Question: Which kind of chart has been used to present this data?
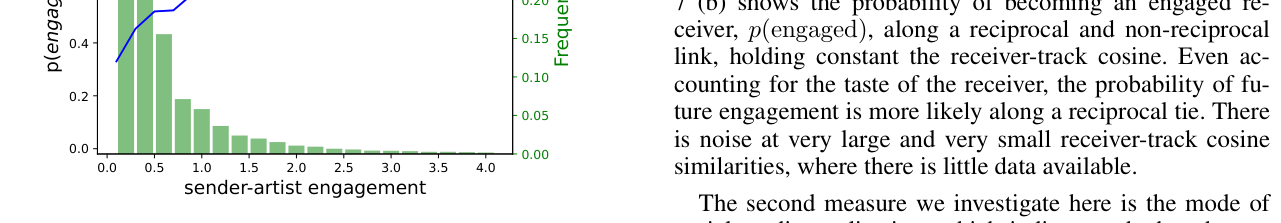
Answer: line